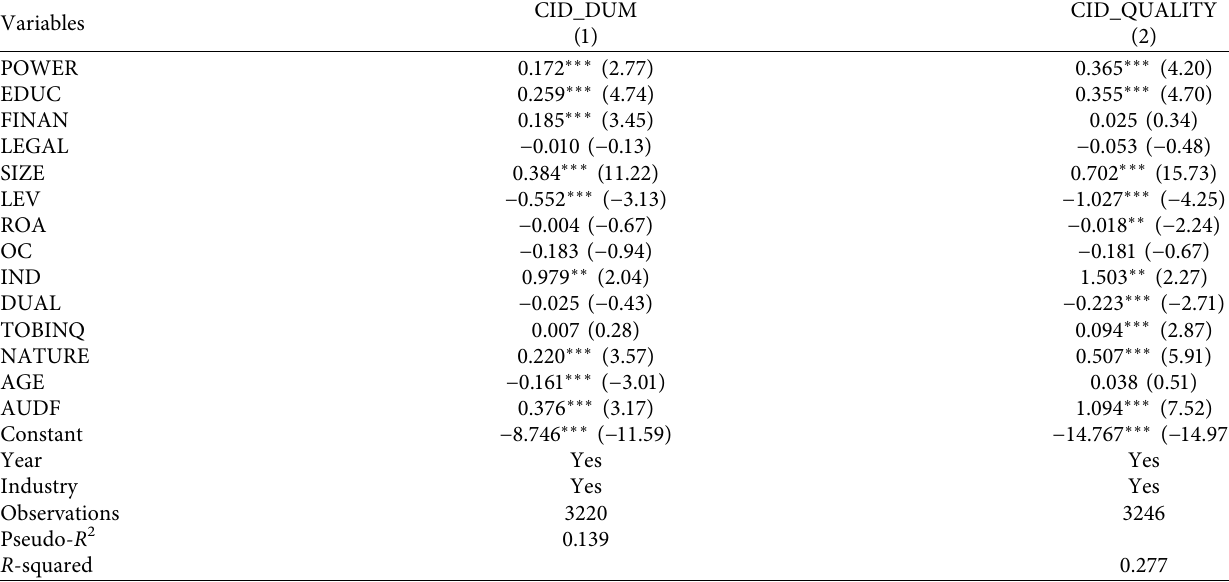
Table 9: The impact of the characteristics of female directors on firms’